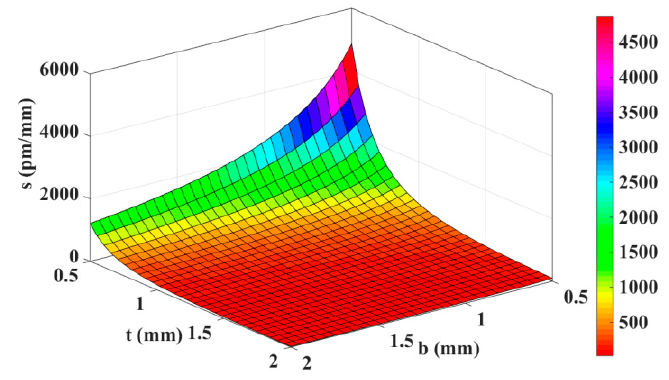
Figure 3. Relationship between sensitivity and elastic ring size.